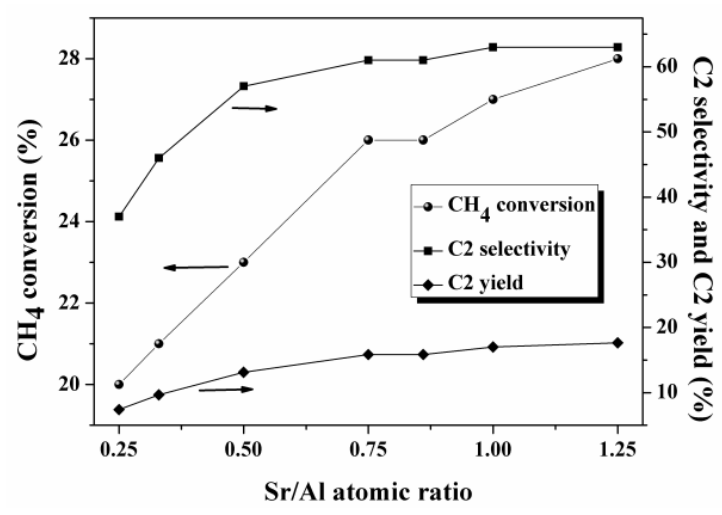
Figure 31. Sr/Al atomic ratio effect on catalytic performance. Reactions were performed at 810 °C, CH 4 /O 2 equal to 5, and total flow of 130 mL·min -1 [160].